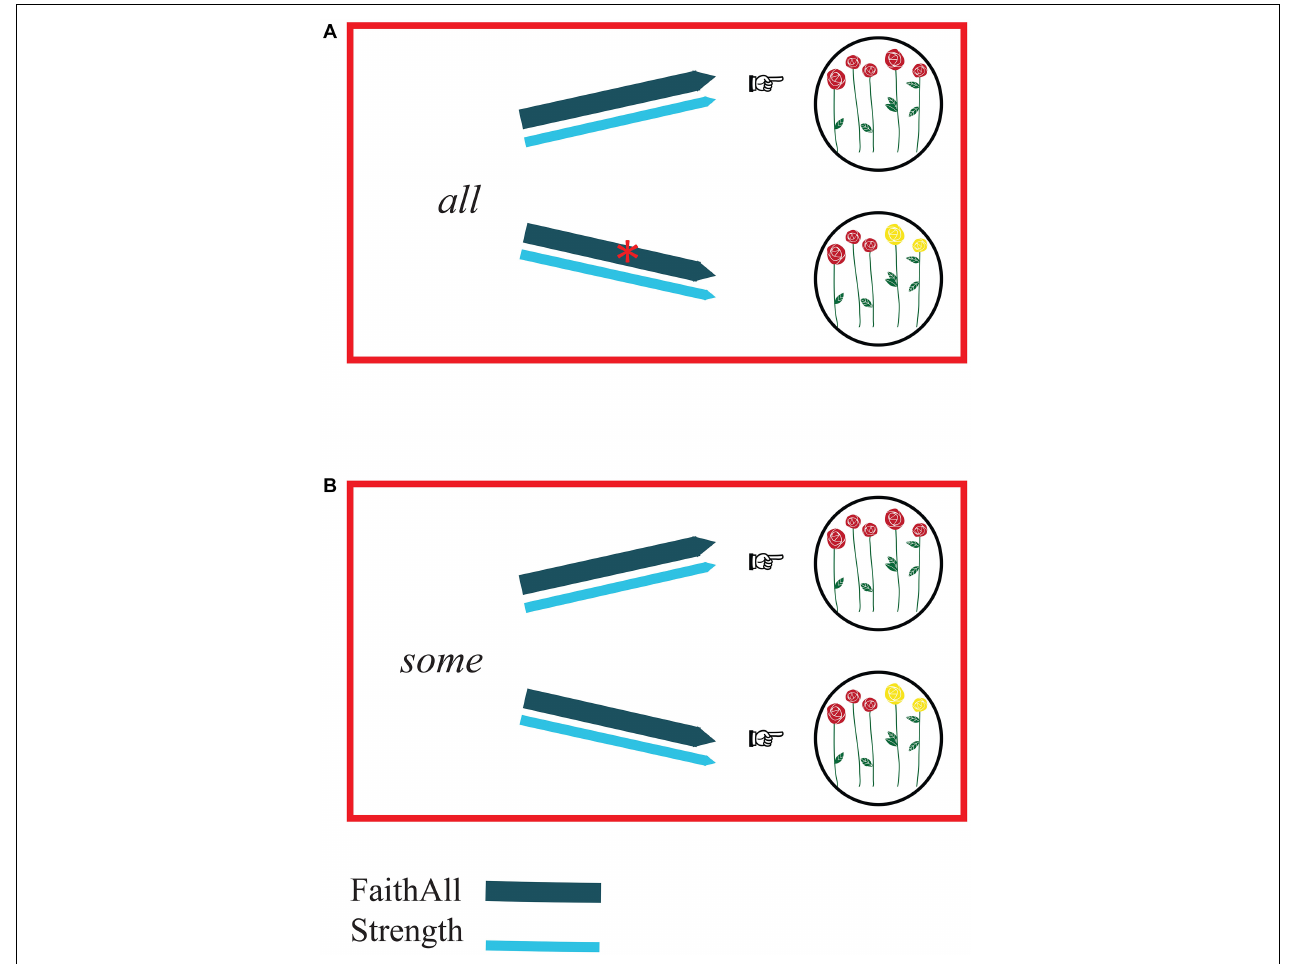
FIGURE 2 | Comprehension (hearers’ perspective). The arrows representing FaithAll (dark blue) and Strength (light blue) link forms with possible meanings. As in Figure 1, constraint violations are represented by red asterisks on the arrows, the relative strength of the constraints is indicated by the weight of the line of the arrows, and pointing fingers indicate which meaning proves to be optimal on the basis of the constraints. Panel (A) illustrates the comprehension of the form all : FaithAll rules out the interpretation consisting of a non-complete set of elements, whereas Strength does not have any effect. The optimal interpretation appears to be the one consisting of a complete set of elements (here: the complete set of flowers). Panel (B) illustrates the comprehension of the form some . In this case, both interpretations are possible, because, irrespective of the chosen interpretation, neither FaithAll nor Strength are violated. So, the form some turns out to be ambiguous between two interpretations: a complete set of elements (here: the complete set of flowers) and a non-complete set of elements (here: a subset of flowers) are both optimal